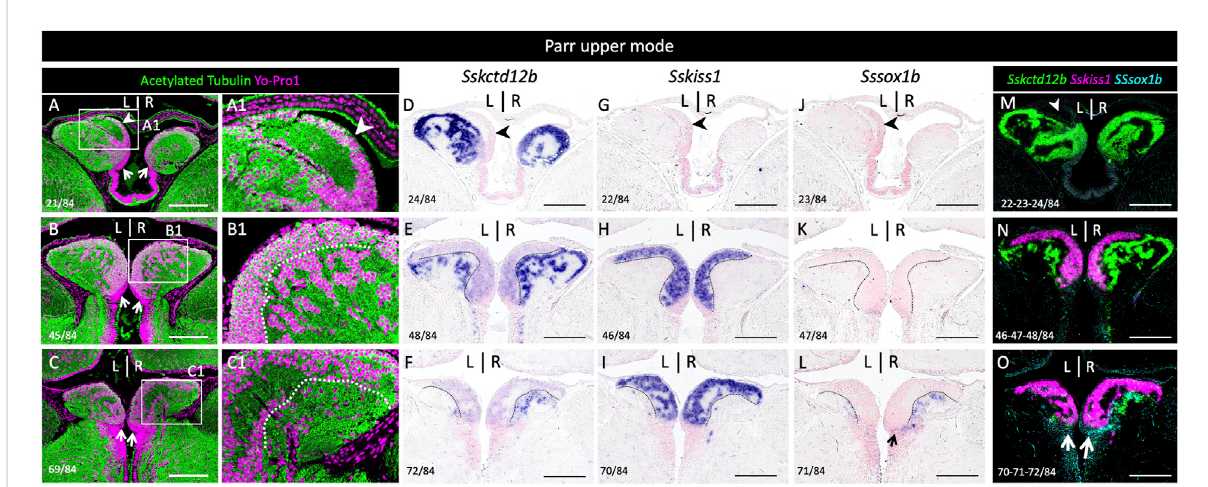
FIGURE 3 Distinct cellular organizations in Sskctd12b, Sskiss1, Sssox1b habenular territories. (A – L) show horizontal sections of habenulae in a parr upper mode following IHC with an antibody directed against acetylated tubulin (green) and Yo-Pro1 staining (purple) (A – C) , ISH with probes for Sskctd12b (D – F) , Sskiss1 (G – I) , Sssox1b (J – L) . (A – L) are adjacent sections at respectively anterior, medial and posterior organ levels, approximately corresponding to those shown in Figures 2A – C. (A1) , (B1) , (C1) show higher magni fi cations of the areas boxed in (A) , (B) , (C) respectively. Numbers in the bottom left corner of each panel indicate section numbers along the dorso-ventral axis. A dotted line delimits the Sskiss1 posterior border in (B,C,E,F,H,I,K,L) . White (A) or black (D,G,J) arrowheads point towards the dorsal kctd12b negative territory. Thin arrows point towards Sssox1b positive neural progenitors. (M,N,O) show alignments of Sskctd12b, Sskiss1 and Sssox1b territories based on adjacent sections. Same abbreviations as in Figure 1. Scale bars = 200 μ m.